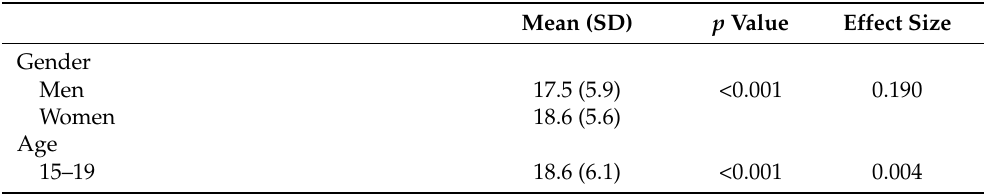
Table 2. Mean (standard deviation: SD) of Fear of COVID-19 Scale